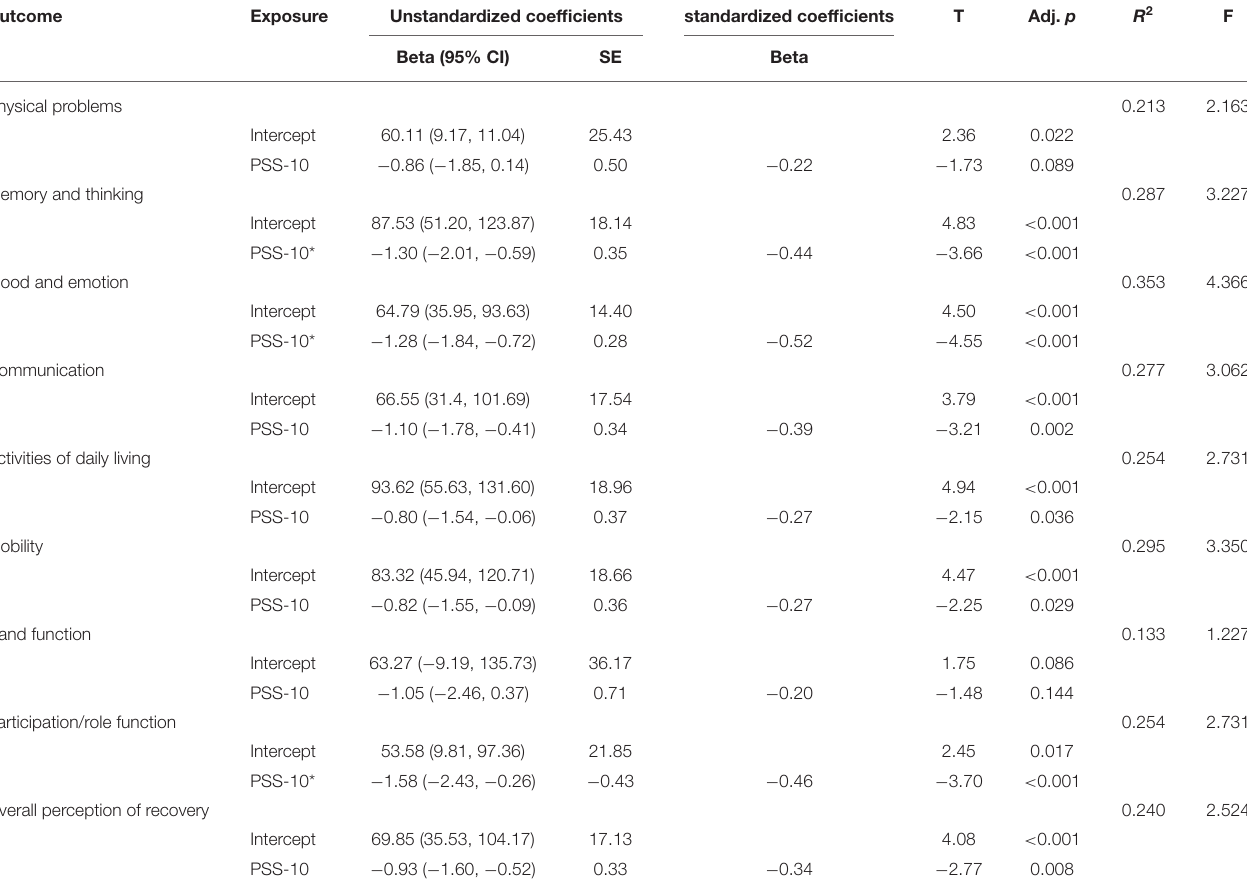
TABLE 4 | Main effect of perceived stress (PSS-10) on Stroke Impact Scale (SIS).